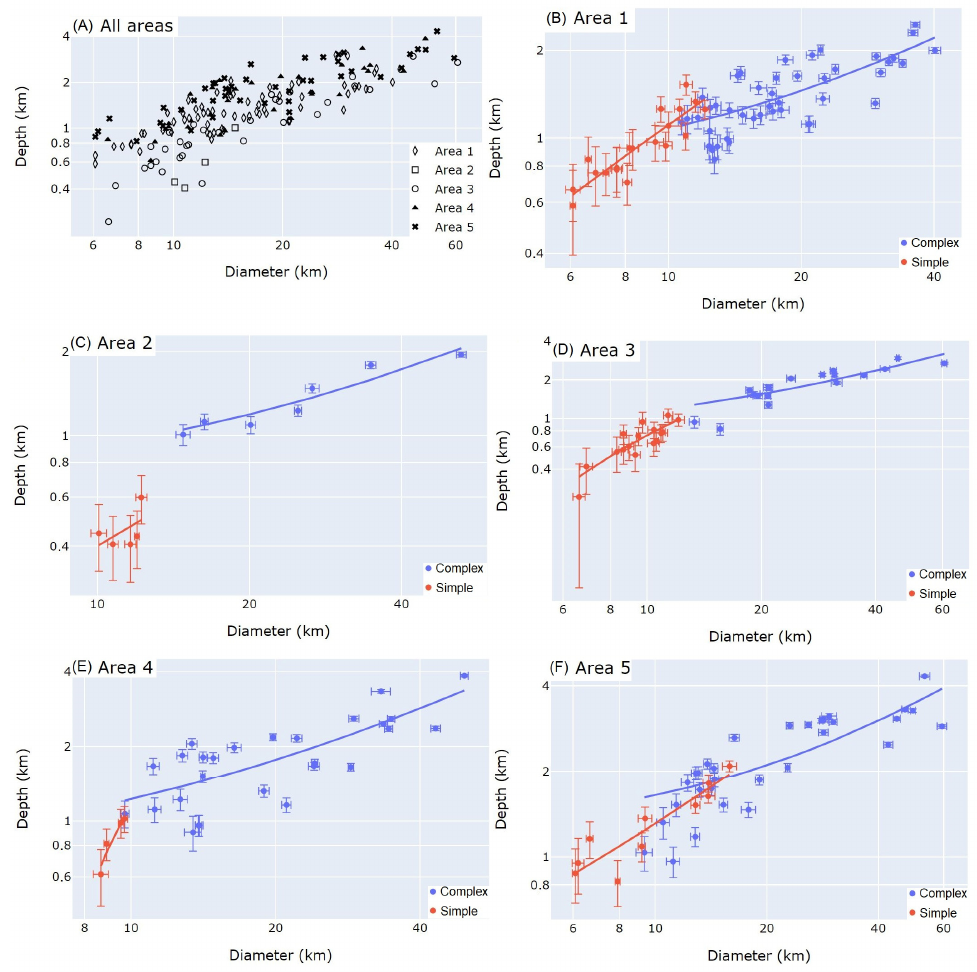
Figure 7. Depth vs Diameter plotted on log–log scale. Only the freshest craters of each area are considered. Data are divided into simple and complex structures. ( A ) all areas. ( B ) area 1 ( C ) area 2. ( D ) Area 3. ( E ) Area 4. ( F ) Area 5.